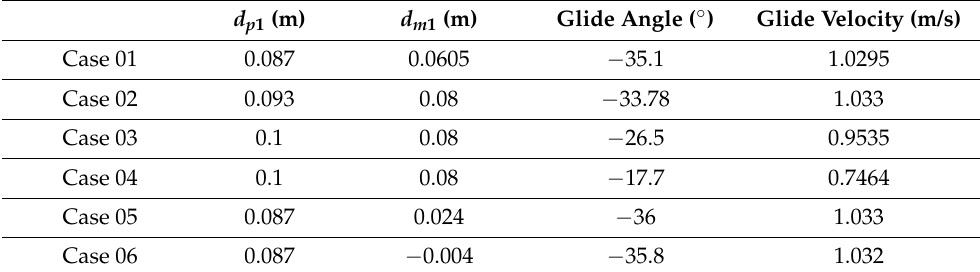
Table 5. Parameters for cases 01 to 06 at maximum gliding